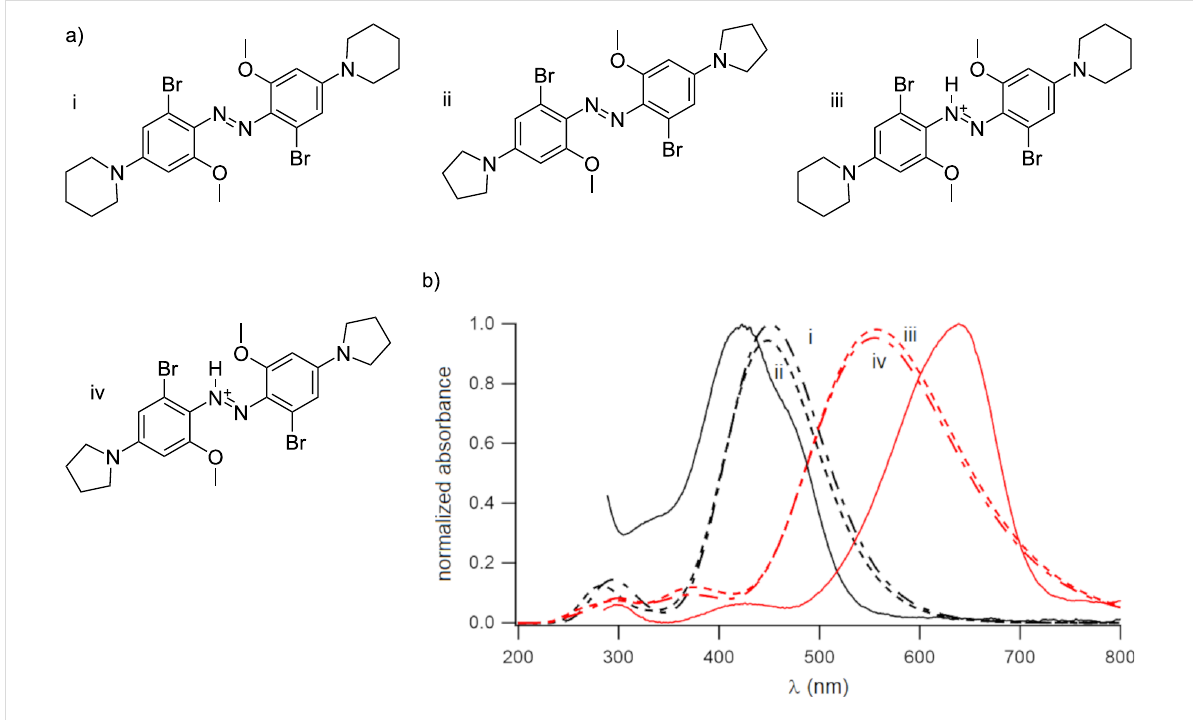
Figure 2: a) Structures of model compounds used for computations (see Experimental section; in calculations, water was set as the solvent). b) Calculated spectra of neutral forms i and ii (black spectra) and azonium forms iii and iv (red spectra), carrying either para -piperidino (i and iii, dashed lines) or para -pyrrolidino (ii and iv, dash-dotted lines) substituents. Solid lines show experimental spectra of 4 in DCM ( c ≈ 15 µM) without (black) or with TFA added